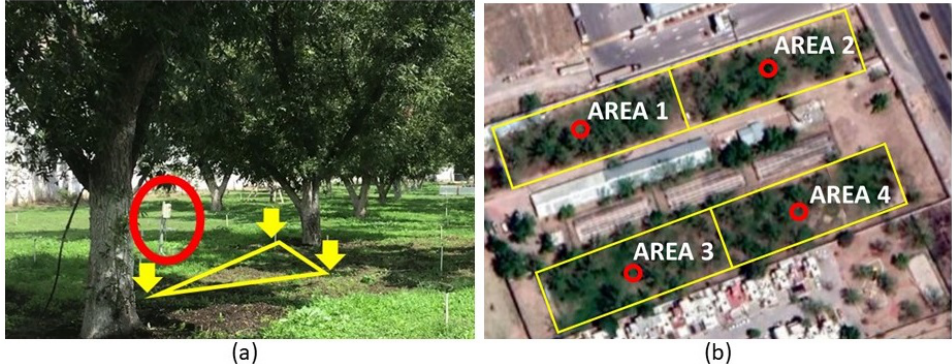
Figure 1. Experimental pecan crop field with the sensor node locations illustrated with the red circles: ( a ) Area 1 lateral view; yellow arrows indicate the sensor placements. ( b ) Satellite view.